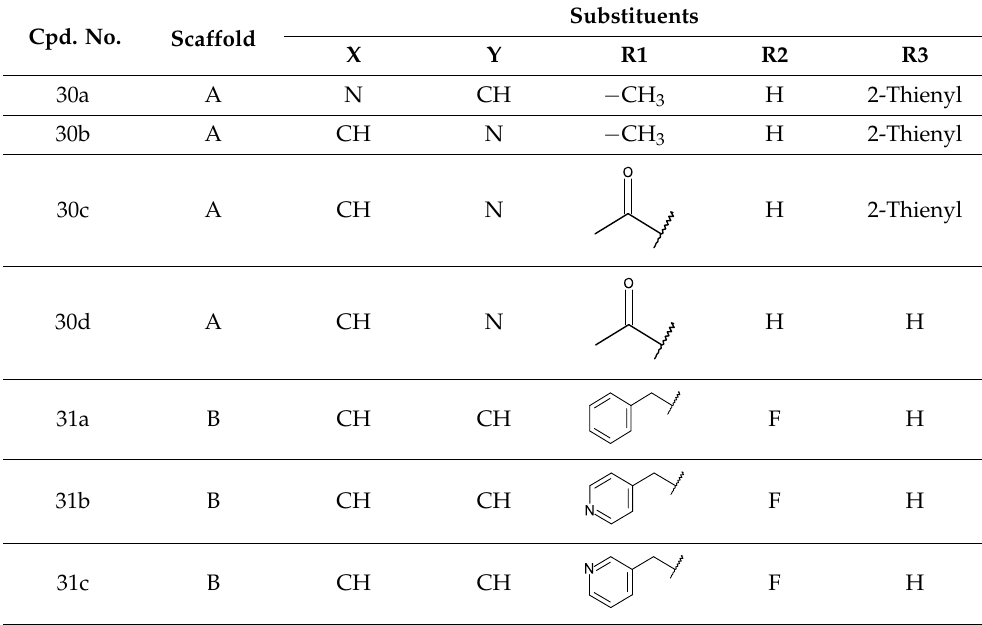
Figure 8. General structure of the test set molecules. Table 3. Structures of the novel inhibitors (test set). Cpd. No.